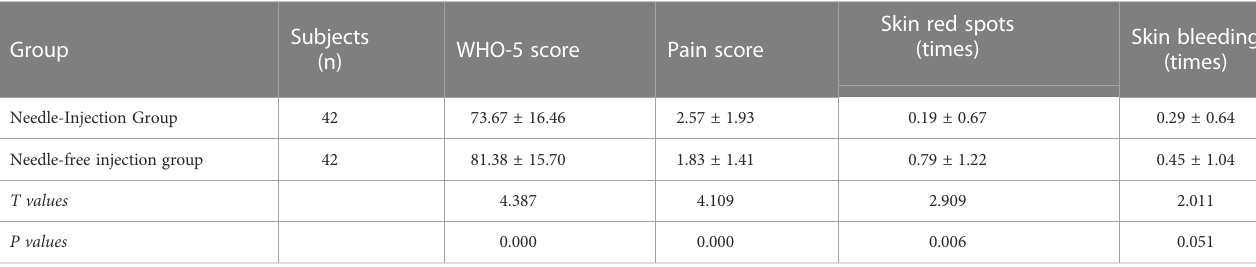
TABLE 3 Comparison of the effects of the two injection methods on satisfaction indicators ( (cid:1) x sd ).